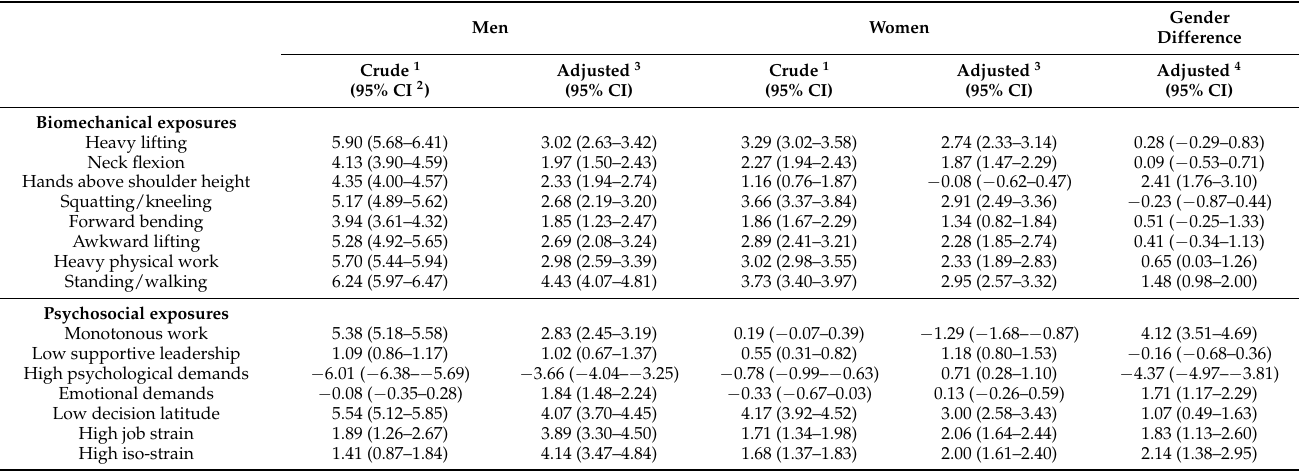
Table 3. Difference in mean estimated time (months) until all-cause withdrawal from paid employ- ment between non-exposed and exposed workers in paid employment at age 62, and the gender difference in this difference.